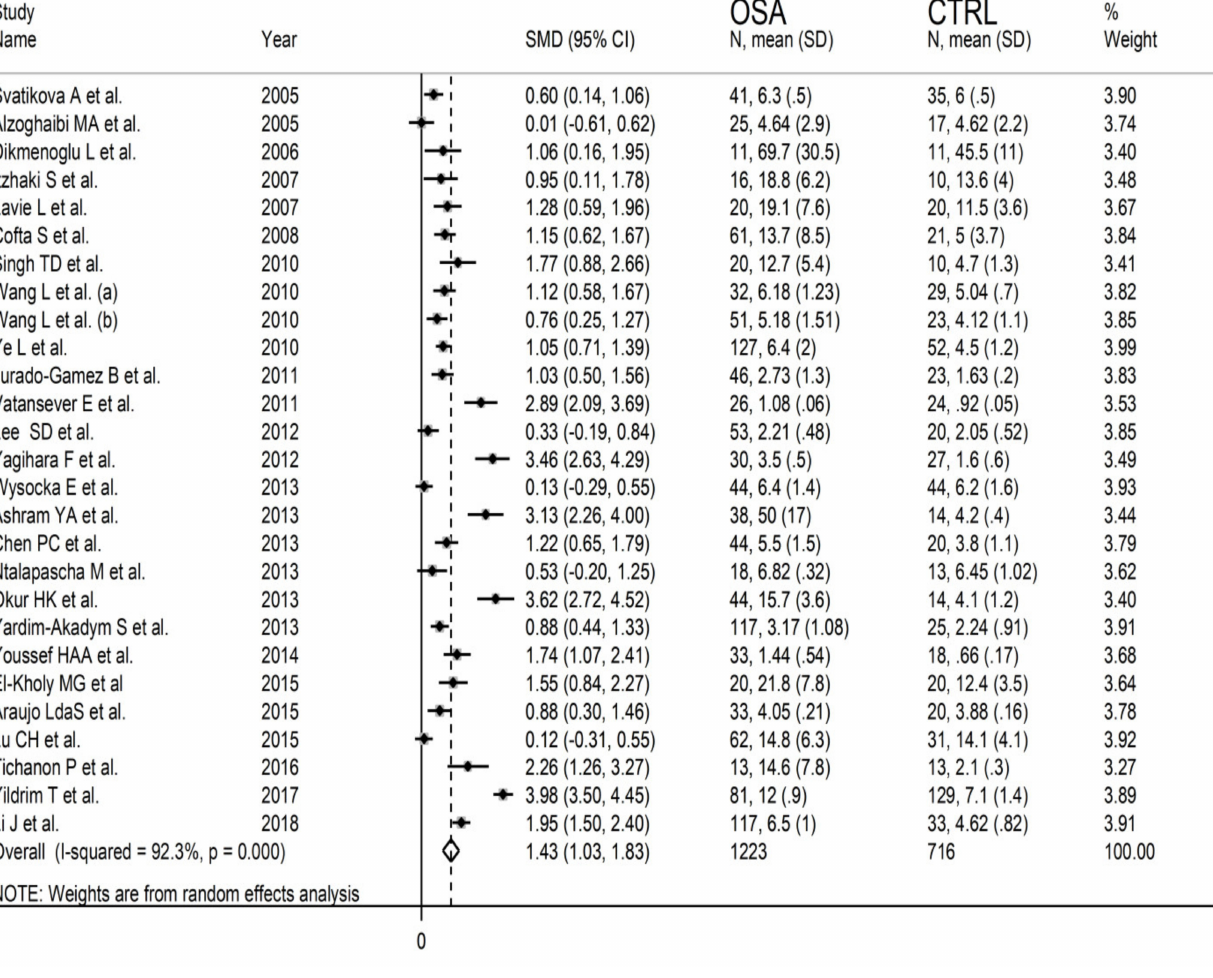
Figure 2. Forest plot of studies investigating MDA concentrations in OSA patients and